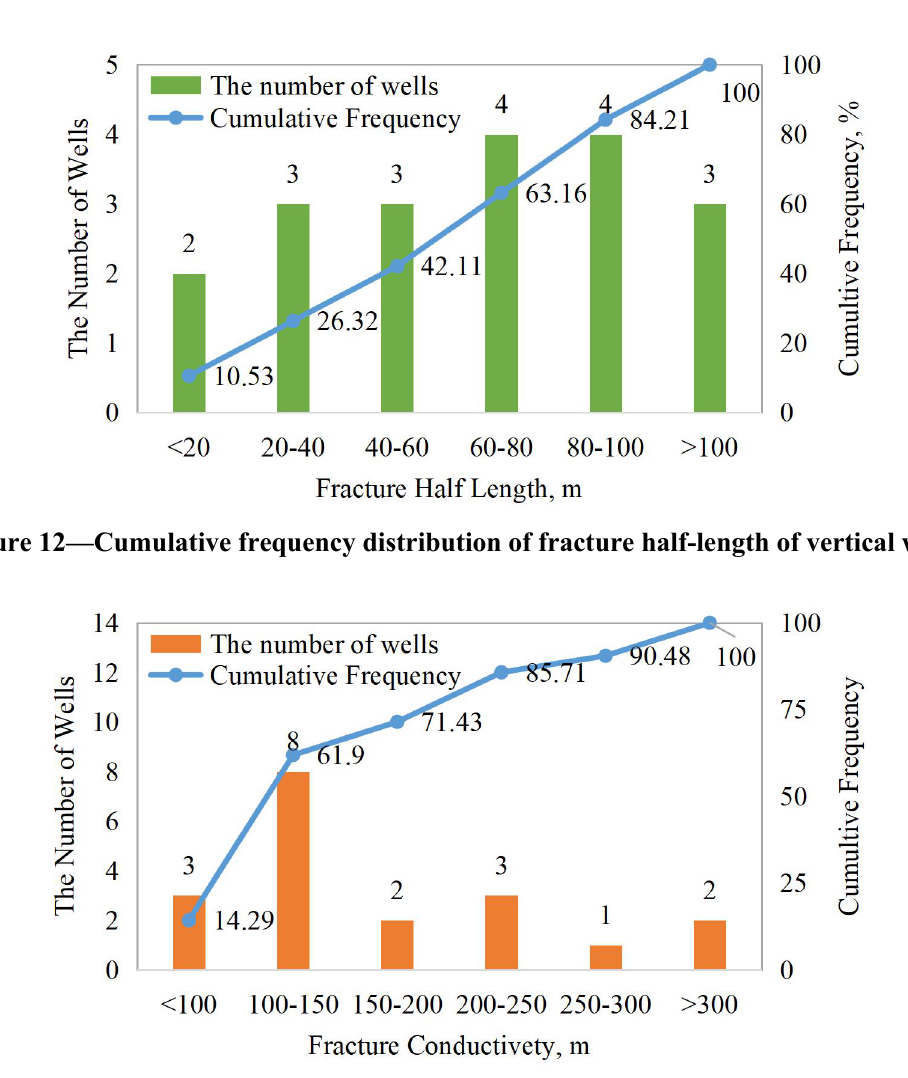
Figure 13—Cumulative frequency distribution of fracture conductivity of vertical wells.